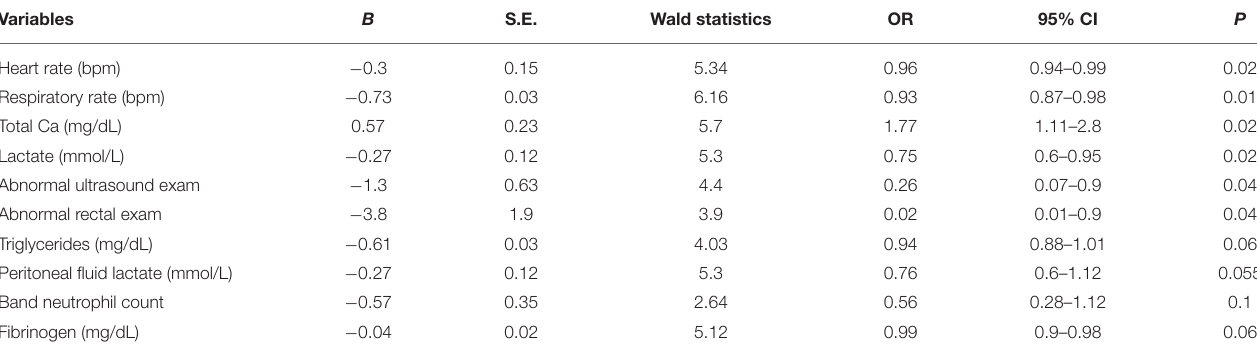
TABLE 4 | Univariate logistic regression analysis for survival in the retrospective study. Variables